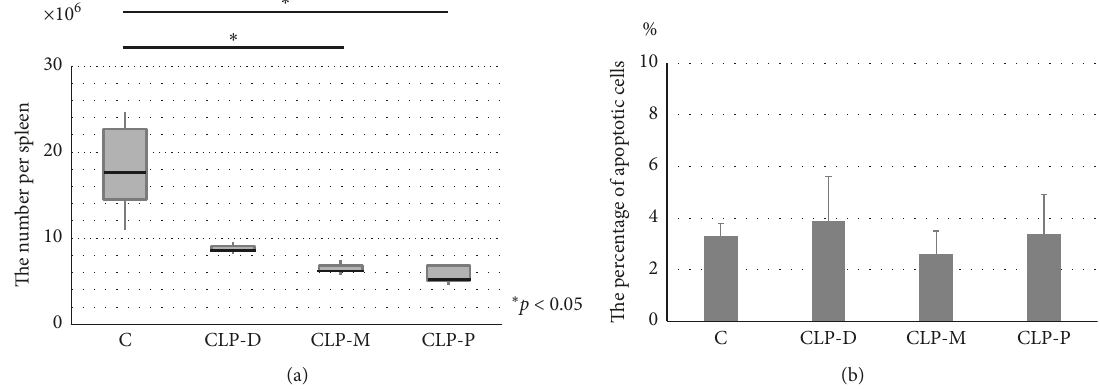
Figure 1: (a) Normal splenic T-lymphocyte numbers in sham operation mice (C) n � 5) and cecum ligation and puncture (CLP) mice at 3 different sites (CLP-D: cecal quarter site proximal to the ileocecal valve, CLP-M: midcecum, and CLP-P: cecal quarter site distal to the ileocecal valve; n � 5 per group). Normal T-lymphocyte numbers were decreased in proportion to CLP severity. (b) The percentage of T- lymphocyte apoptosis in 4 groups (C, CLP-D, CLP-M, and CLP-P). There were no significant differences in the percentage of apoptosis between the 4 groups. C: group C which received sham operation; CLP-D: group CLP-D which received CLP at the distal cecum; CLP-M: group CLP-M which received CLP at the midcecum; CLP-P: group CLP-P which received CLP at the proximal cecum.